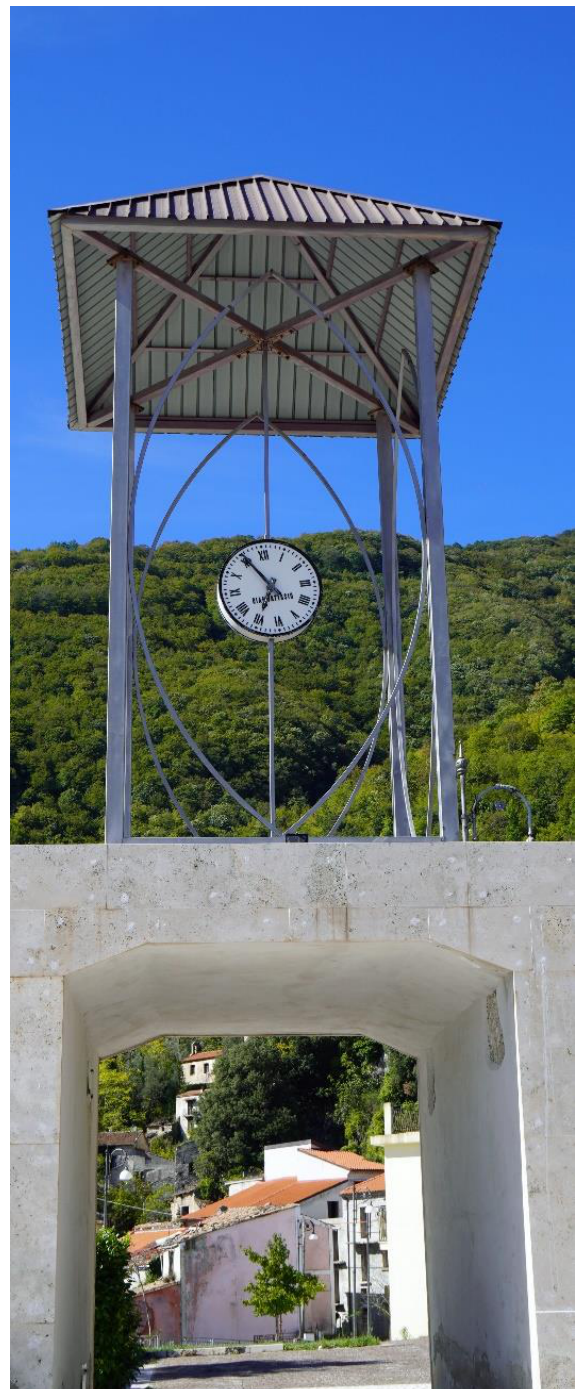
Figure 97. Senerchia: the new village, “Piazza 23 Novembre 1980” and monument dedicated to the earthquake victims (photos by [35,36]).